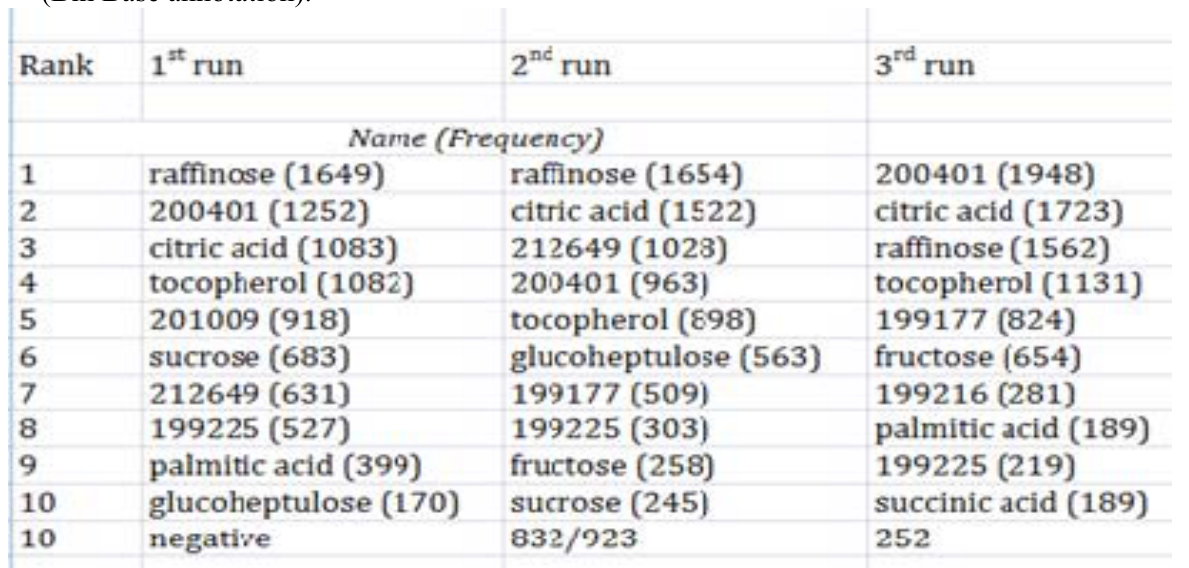
Table 1. Top 10 classifiers from three identical independent runs on GC-TOF-MS data (Bin Base